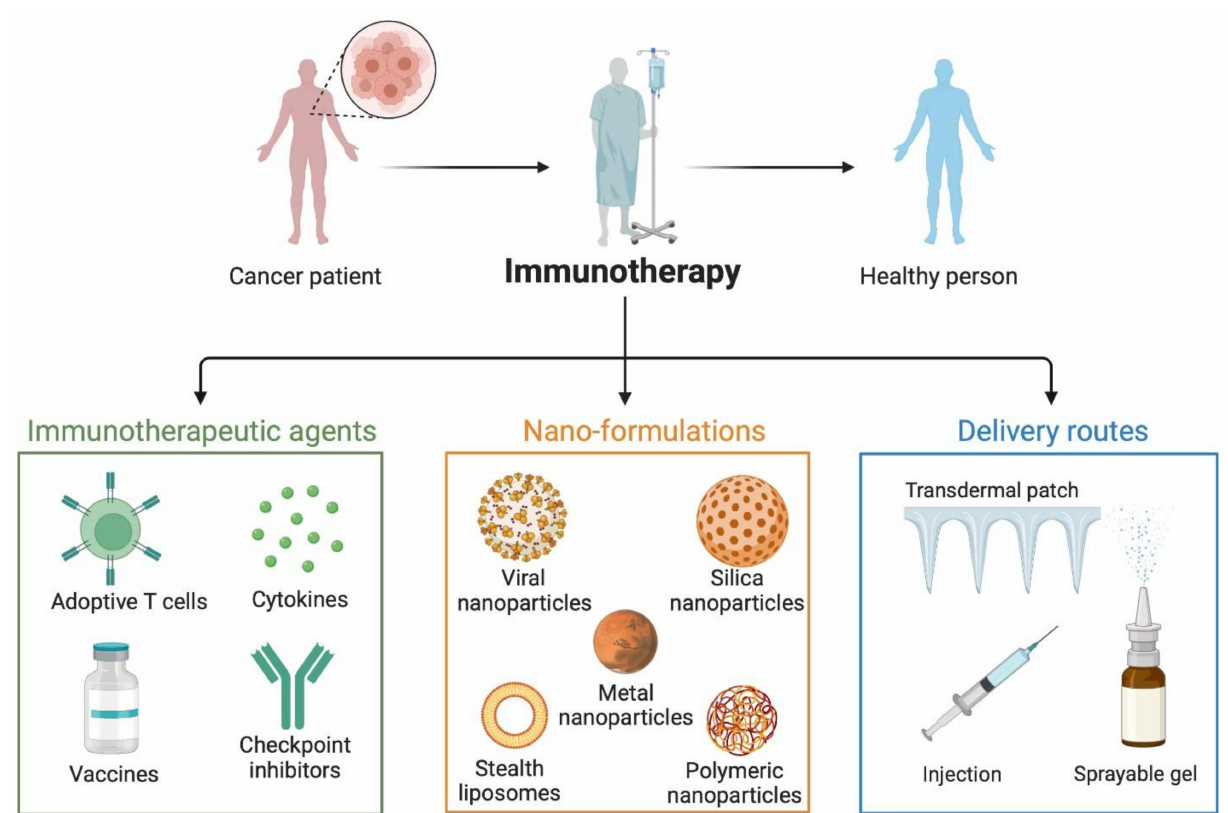
Figure 2. Various nanomedicine enhanced cancer immunotherapy